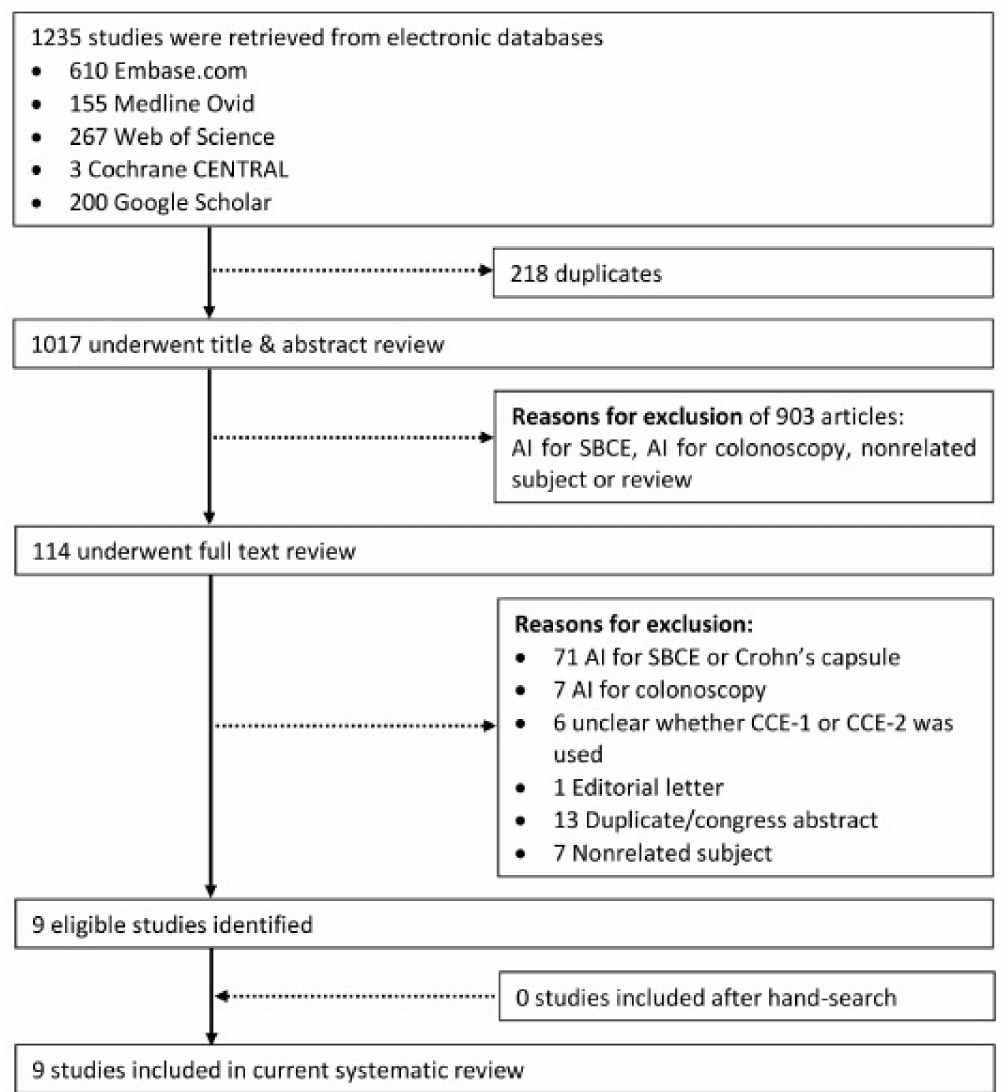
Figure 1. Flow chart of study